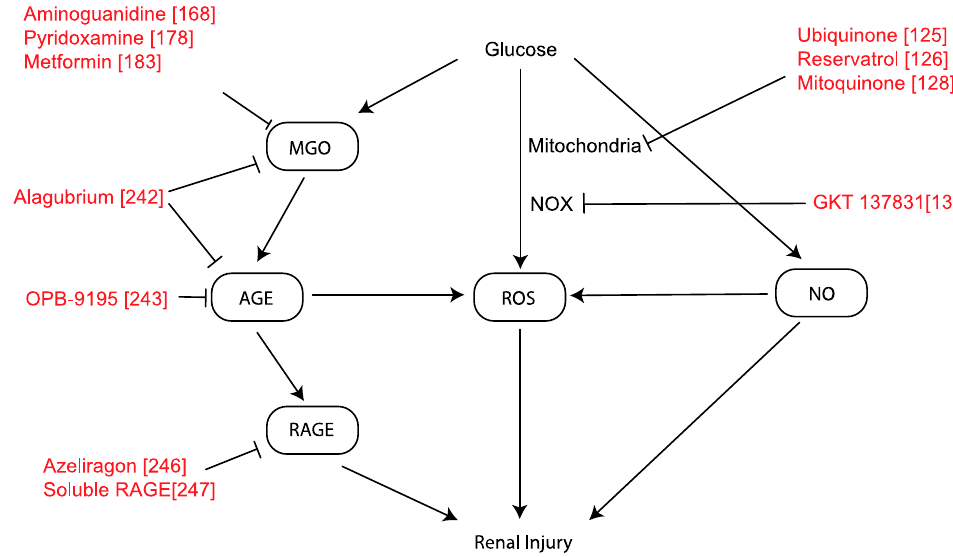
Figure 2. Role of glucose in promoting dicarbonyl and oxidative stress and reducing NO availability in order to promote renal injury [125,126,128,134,168,178,183,242,243,246,247].